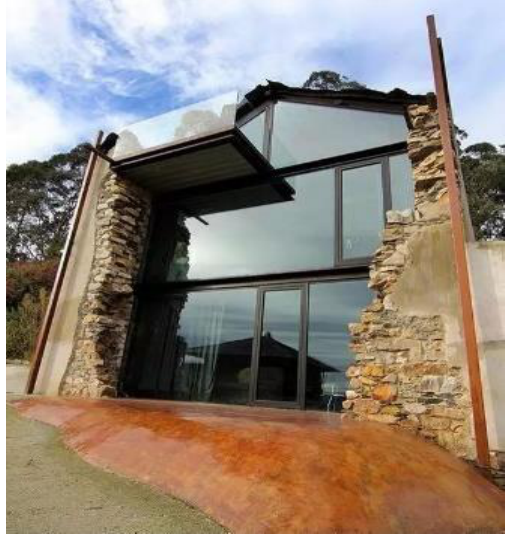
Figure 25. Comparison of the new and the old (source: [51]).